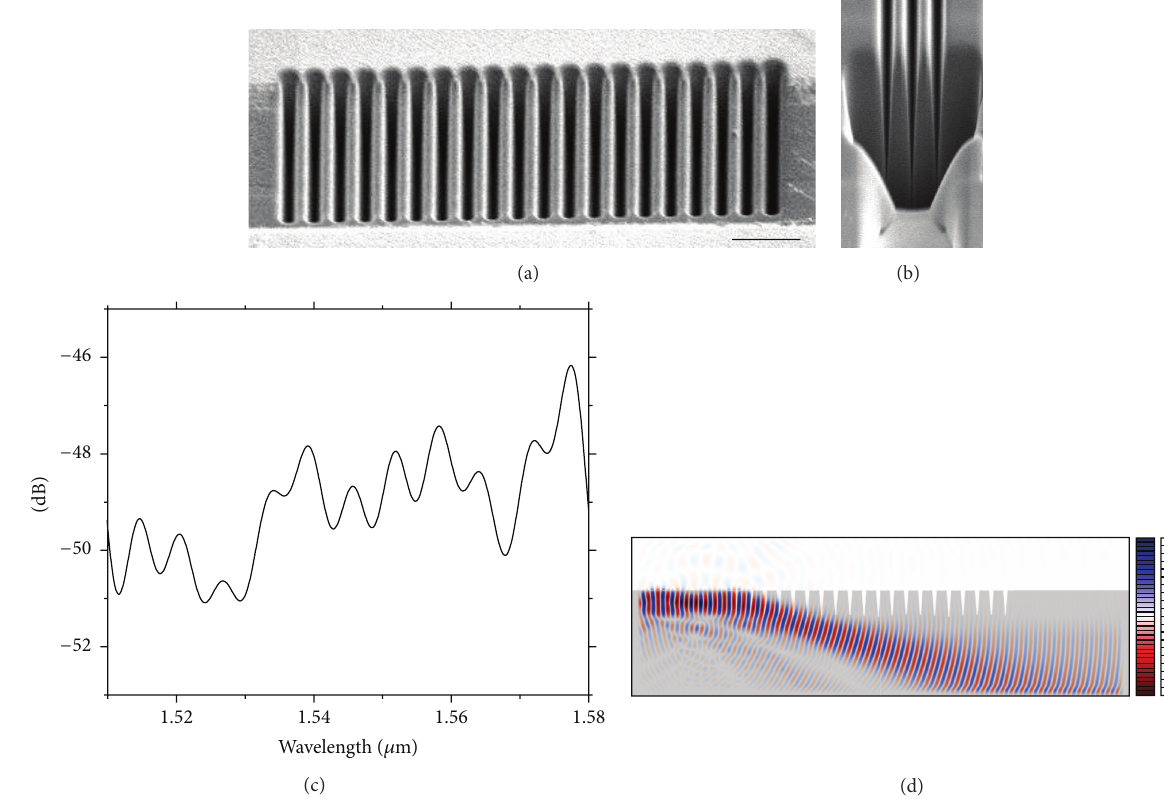
Figure 1: 52 ∘ tilted SEM image of (a) FIB milled Bragg grating on bulk LN (the scale bar denotes 5 𝜇 m) and (b) the trenches with conical cross sections. (c) Transmission spectrum of the structure in panel (a) shows high insertion loss up to 51dB. (d) 𝑋𝑍 -plane (side view) FDTD field simulation showing transmission losses due to vertical plane scattering arising from conicity and poor confinement.